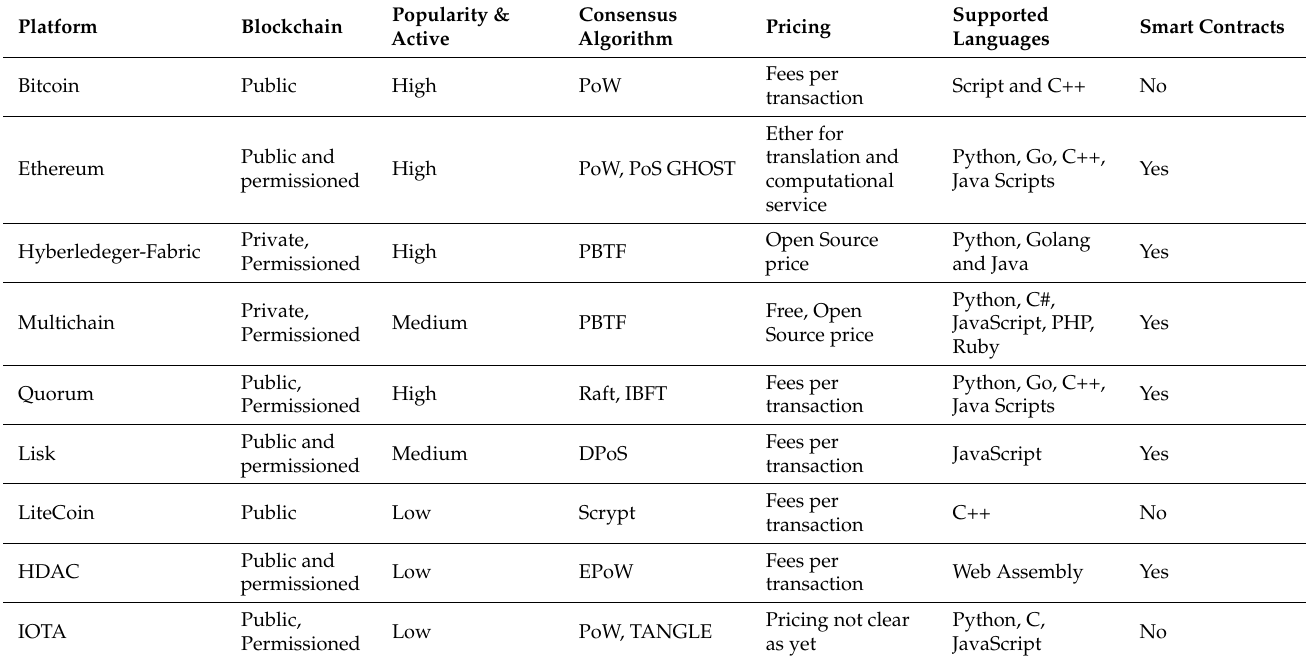
Table 4. Blockchain